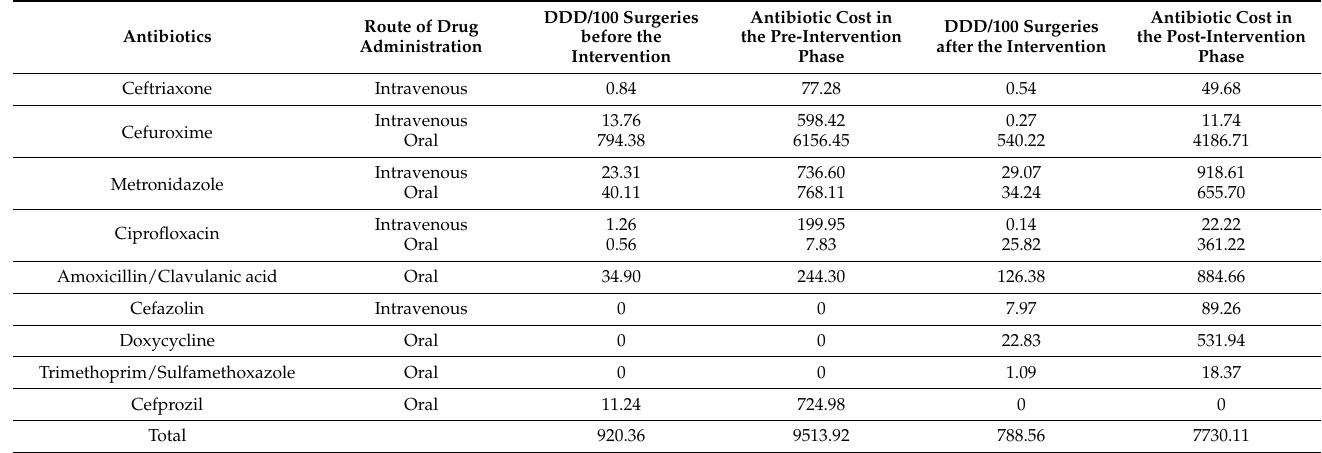
Table 7. Antibiotic cost before and after the